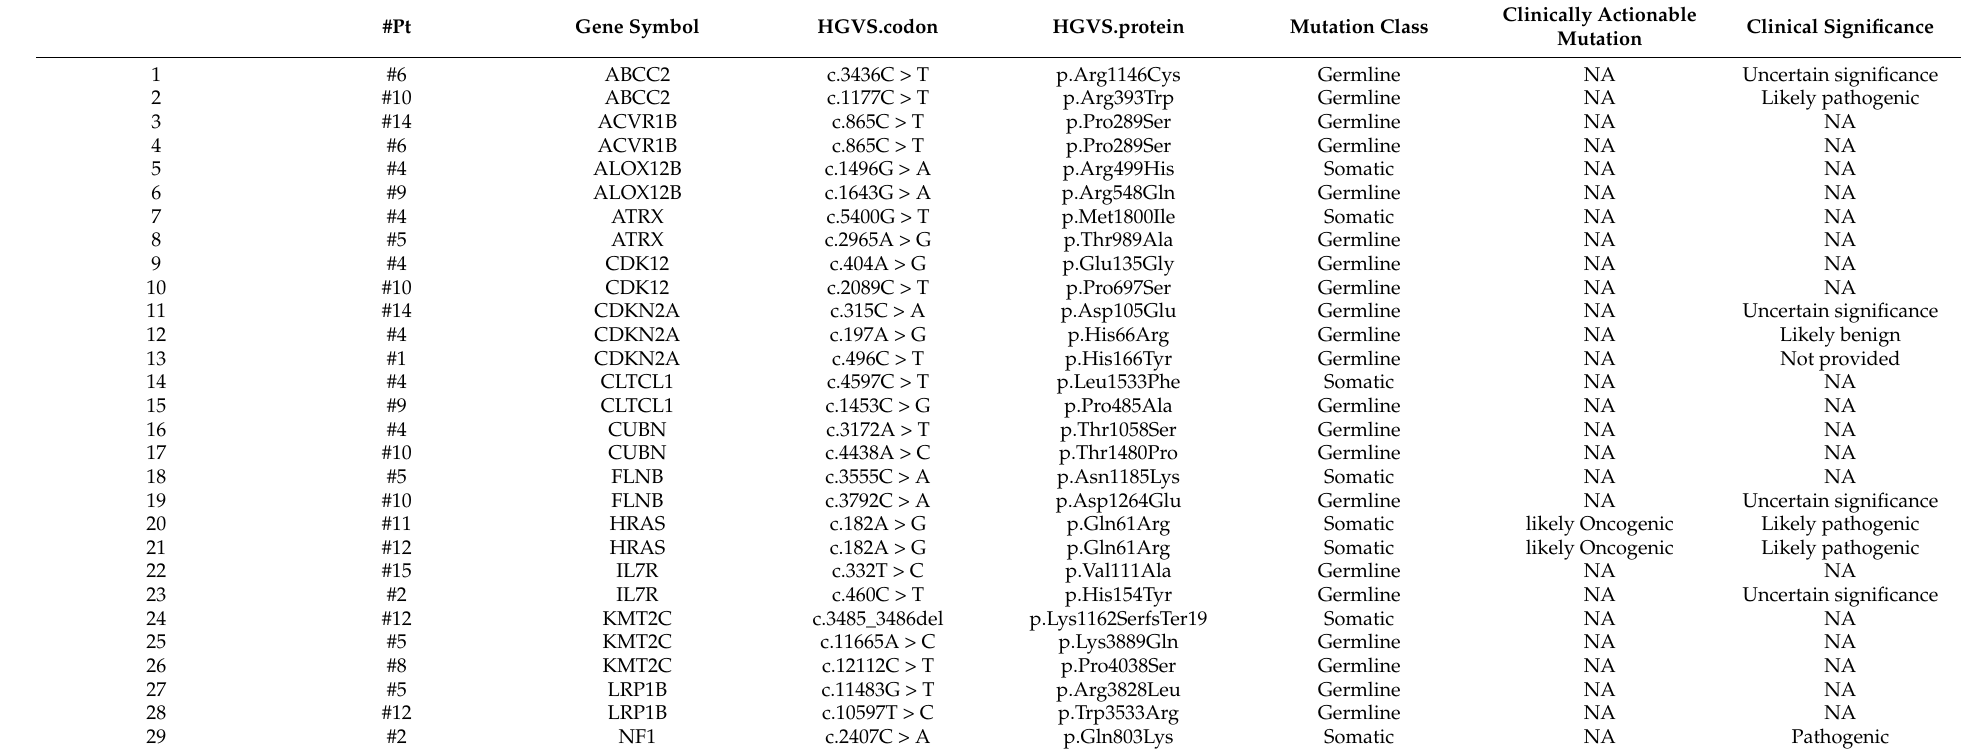
Table 2. Mutations identified in 15 AMC aggressive pheochromocytomas and